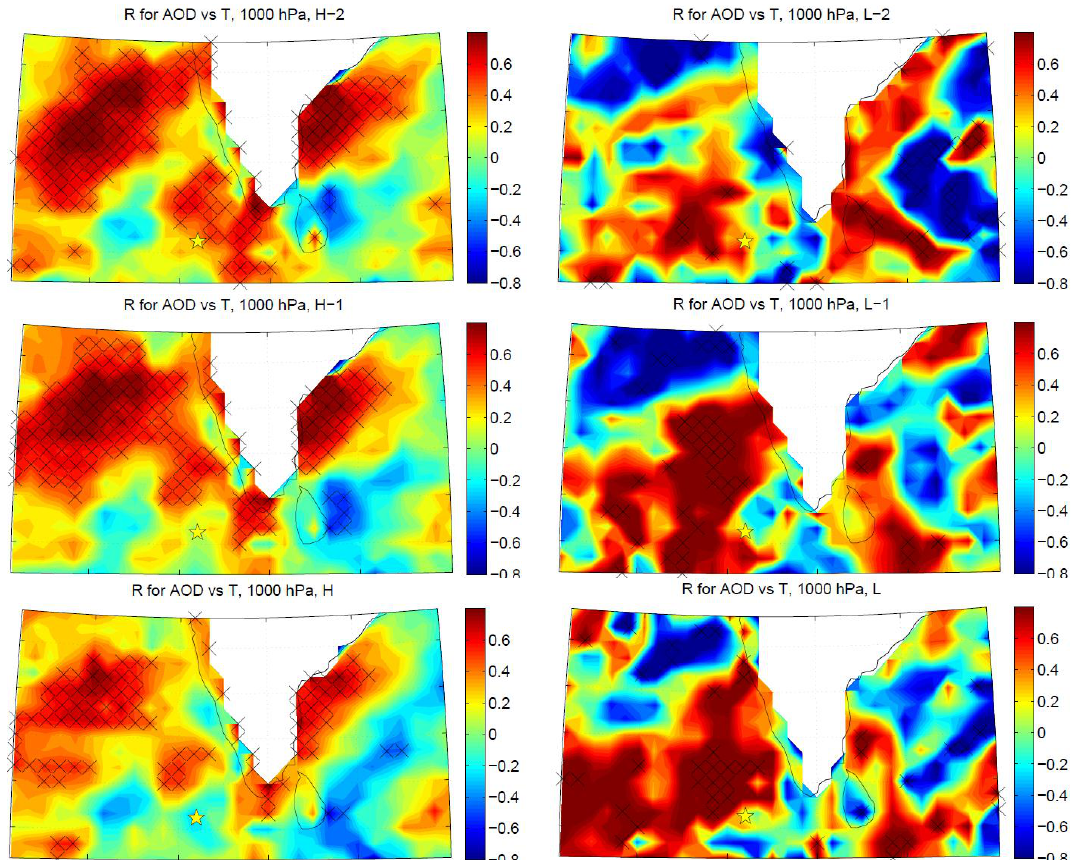
Figure 12. Correlation between AOD and 1000hPa temperature for days leading up to high- (left) or low-pollution (right) events. The bottom row indicates the average of the days classified as a particular pollution event, while the middle and upper rows indicate the averages of the previous 1 and 2 days, respectively. Hatching indicates a statistical significance at the 95%